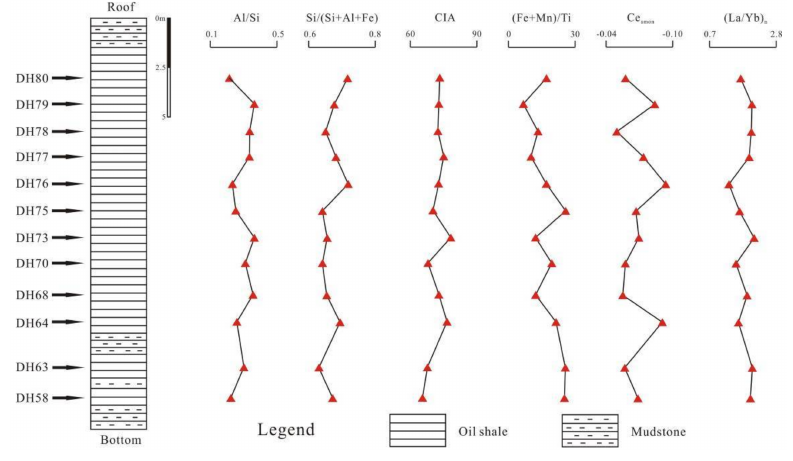
Figure 3. Vertical variation of geochemical parameters of oil shale samples.